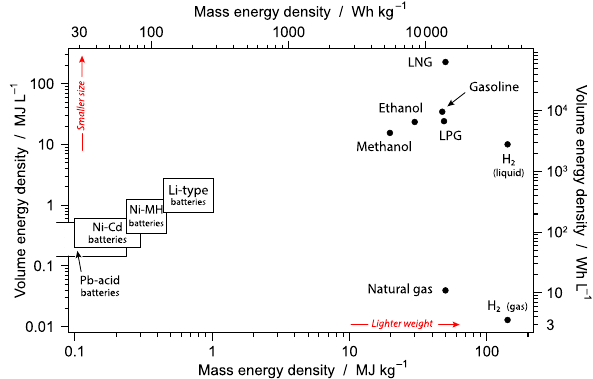
Figure 4. Volume and mass energy densities of some selected bat- teries and liquid fuels. Both MJ and Wh are reported in the dia- gram as energy units (on opposite sides), as both are largely dif- fused in the literature and technical